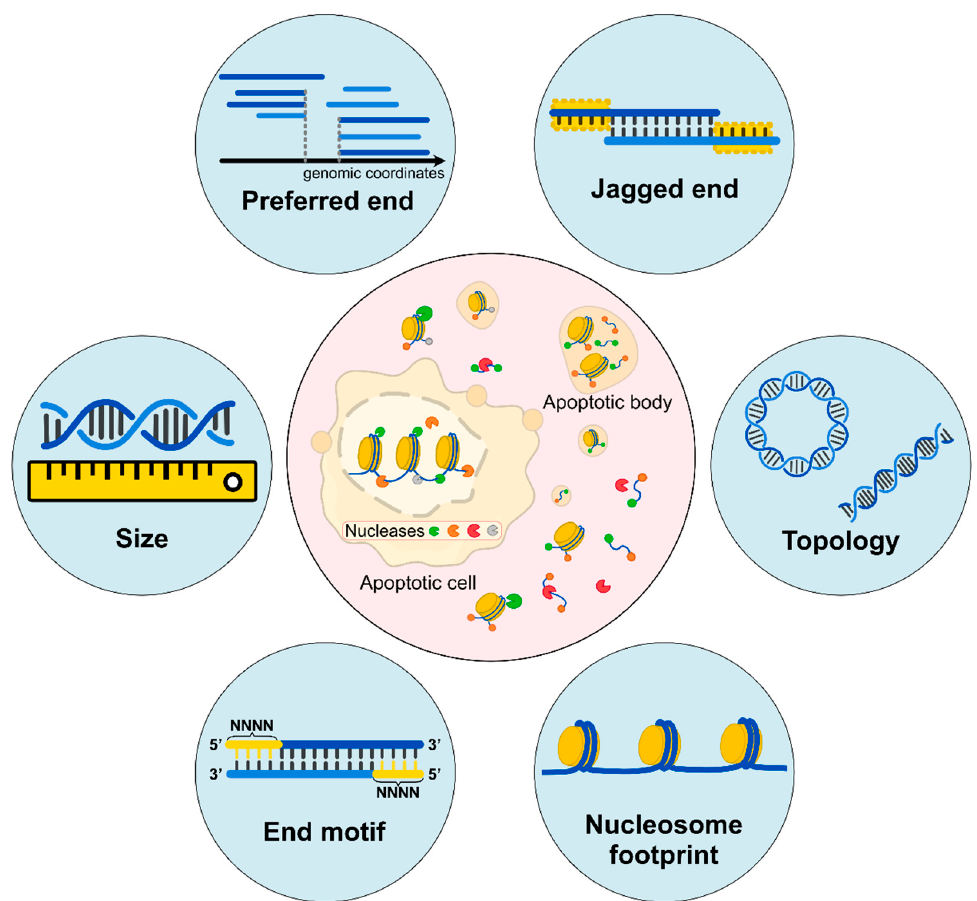
Figure 1. Biological characteristics of cell-free DNA. (Inner circle) Apoptotic cells would release DNA molecules into blood circulation accompanied by the digestion of intracellular Deoxyribonuclease 1 Like 3 (DNASE1L3), DNA Fragmentation Factor Subunit Beta (DFFB), and other nucleases. The released cfDNA molecules are further fragmented by extracellular DNASE1L3, Deoxyribonuclease 1 (DNASE1), and other nucleases. Different ends may represent characteristics of cleavages by various nucleases. (Outer circle) Fragment sizes are deduced by sequencing in single-base resolution; preferred ends are a subset of the genomic coordinates which are preferentially cleaved; jagged ends are single-stranded ends carried by these double-stranded DNA molecules; DNA topology consists of different forms of DNA molecules, including circular and linear forms; nucleosome footprints show different positioning varies among cell types; end motifs refer to several bases of characteristic sequences at the 5’ end of a fragment (e.g., the 4-nucleotide motif). All these characteristics are reflective of diverse fragmentation processes.